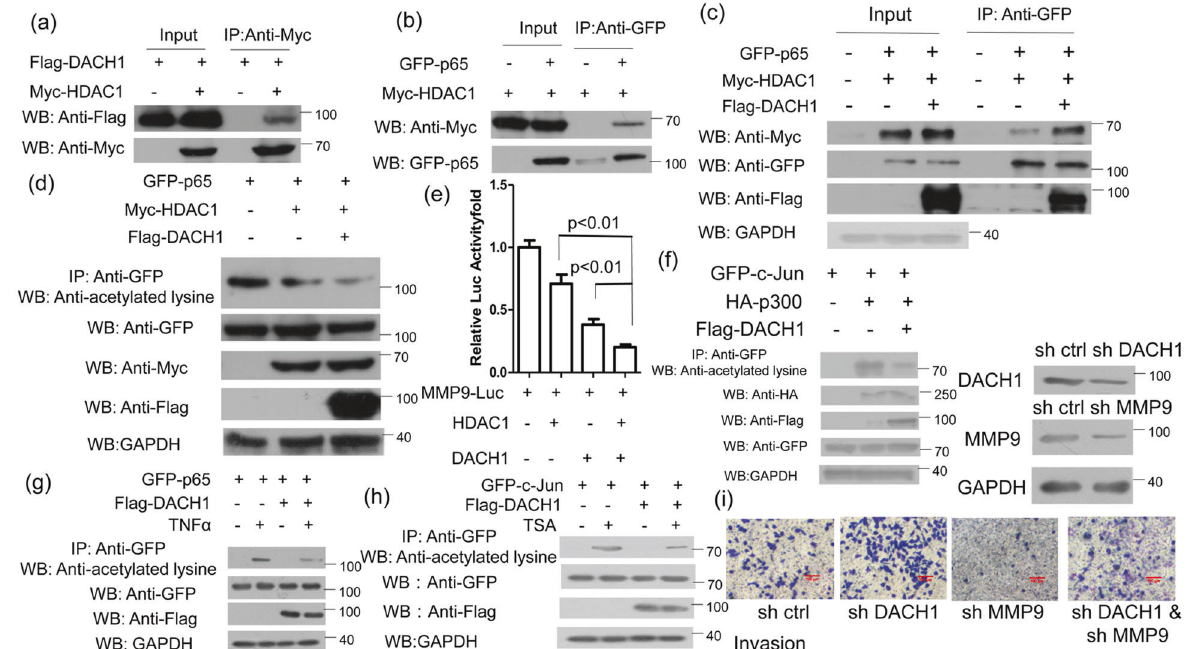
Fig. 5 DACH1 recruits HDAC1 to the NF-kB binding site. a HEK 293 T cells transfected with Flag-DACH1 alone or Flag-DACH1 and Myc- HDAC1 were subjected to immunoprecipitation with anti-Myc antibody followed by western blot with anti-Flag or anti-Myc antibody. b HEK 293 T cells transfected with GFP-p65 alone or together with Myc-HDAC1 were subjected to immunoprecipitation with anti-GFP antibody followed by Western blot with anti-Myc or anti-GFP antibody. c HEK 293 T cells transfected with GFP-p65 and Myc-HDAC1 along with or without Flag-DACH1 were immunoprecipitated with anti-GFP antibody followed by Western blot with anti-Myc, anti-GFP, anti-Flag antibody. d HEK 293 T cells transfected with the indicated plasmids were subjected to immunoprecipitation with anti-GFP antibody followed by Western blot with anti-acetylated lysine antibody. All cells were treated with TNF α (40 ng/ml) for 4 h before harvest. TNF α was used to activate the NF- κ B signaling pathway and promote the acetylation level of p65. e HEK 293 T cells were transfected with MMP9-luc and either HDAC1 or DACH1, HDAC1 and DACH1. f HEK 293 T cells were transfected with the related plasmids for 24 h, and then the cell lysis were subjected to immunoprecipitation with anti-GFP antibody followed by western blot with anti-acetylated lysine antibody. g HEK 293 T cells were transfected with GFP-p65 along with or without Flag-DACH1. Cells were treated with or without TNF α (40 ng/ml) for 4 h before harvest. The lysis were subjected to immunoprecipitated with anti-GFP antibody followed by anti-acetylated lysine antibody. h HEK 293 T cells transfected with the related plasmids for 24 h and then the cells treated by TSA (1 μ M) for 6 h before harvest were immunoprecipitated with anti-GFP antibody followed by western blot with anti-acetylated lysine antibody. i MCF7 cell invasion assays was performed in 24-well chambers with Matrigel. Cells were transfected with sh Ctrl, sh DACH1, sh MMP9 or sh DACH1 and sh MMMP9, and then inoculated into the upper chamber. After cultured 24 h, cells on the lower surface of the fi lter were stained and photographed. The scale bars stand for 100 μ m. Luciferase activity